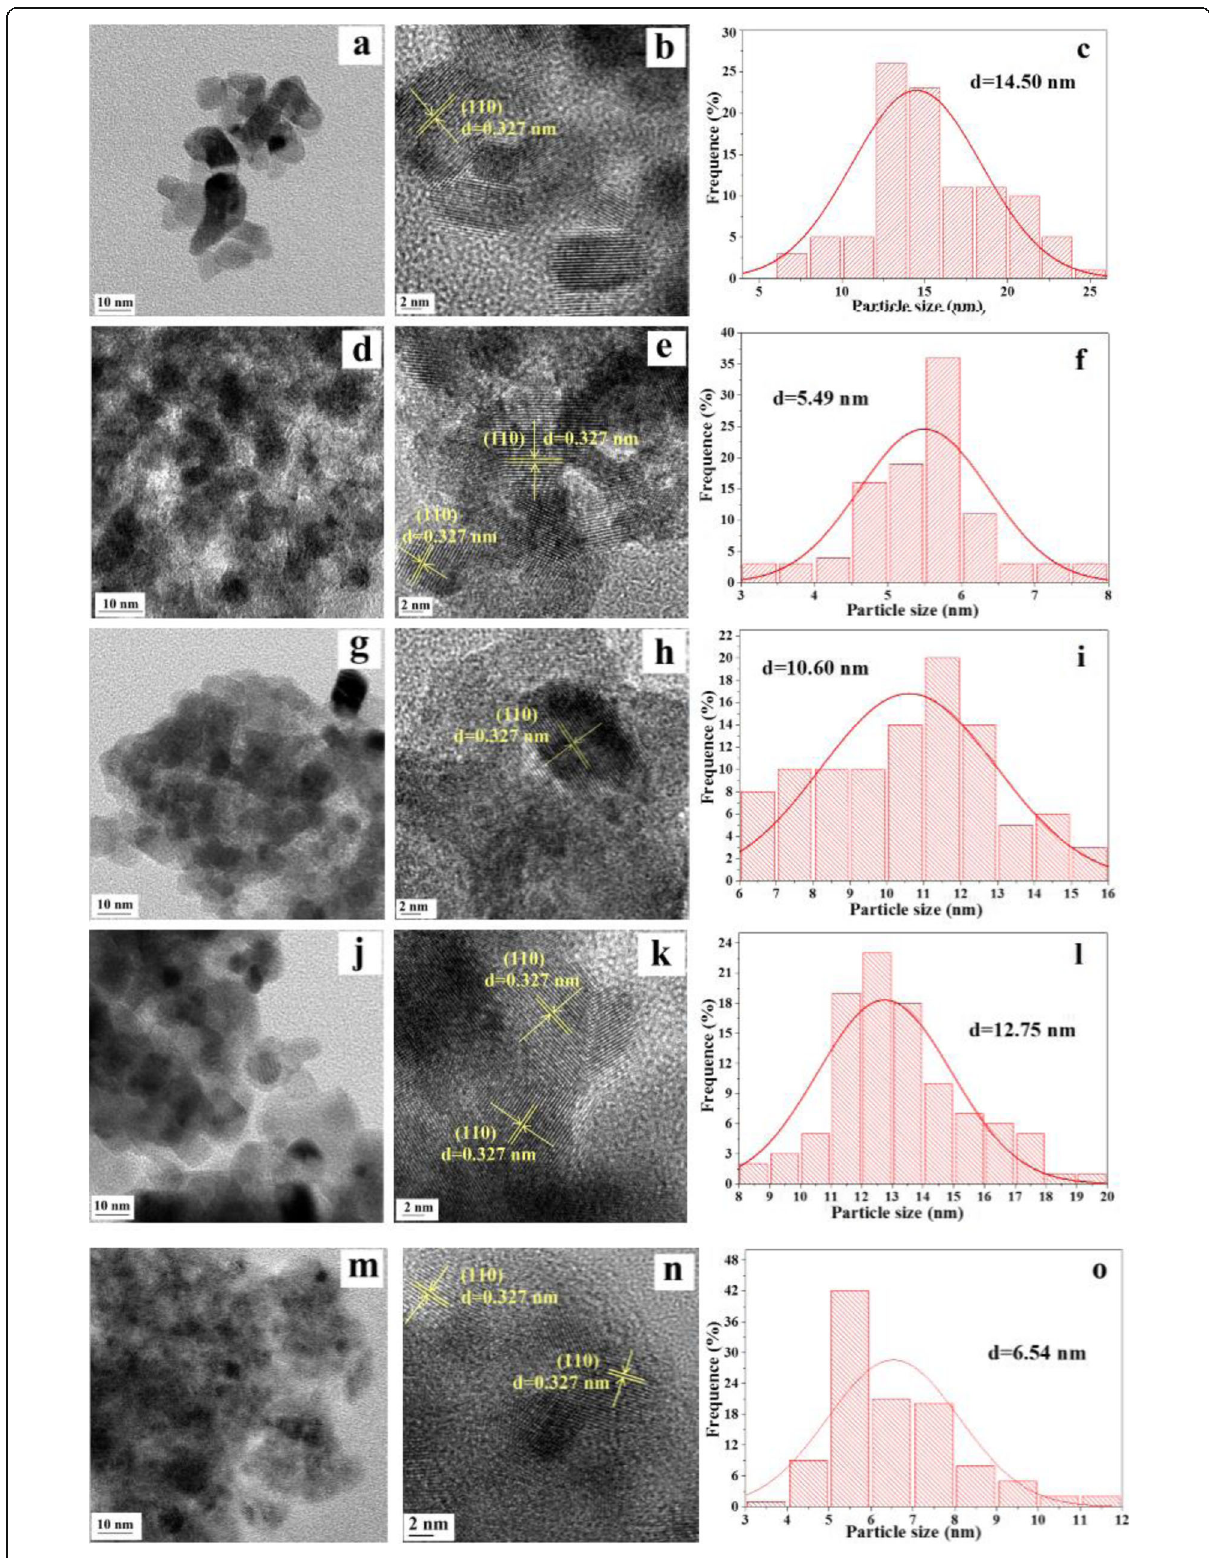
Fig. 7 TEM, HRTEM images, and the particle size distribution of a , b , c Ru/SnO 2 ; d , e , f Ru/Sn 0.67 Ti 0.33 O 2 ; g , h , i Ru/Sn 0.5 Ti 0.5 O 2 ; j , k , l Ru/ Sn 0.33 Ti 0.67 O 2 ; and m , n , o Ru/TiO